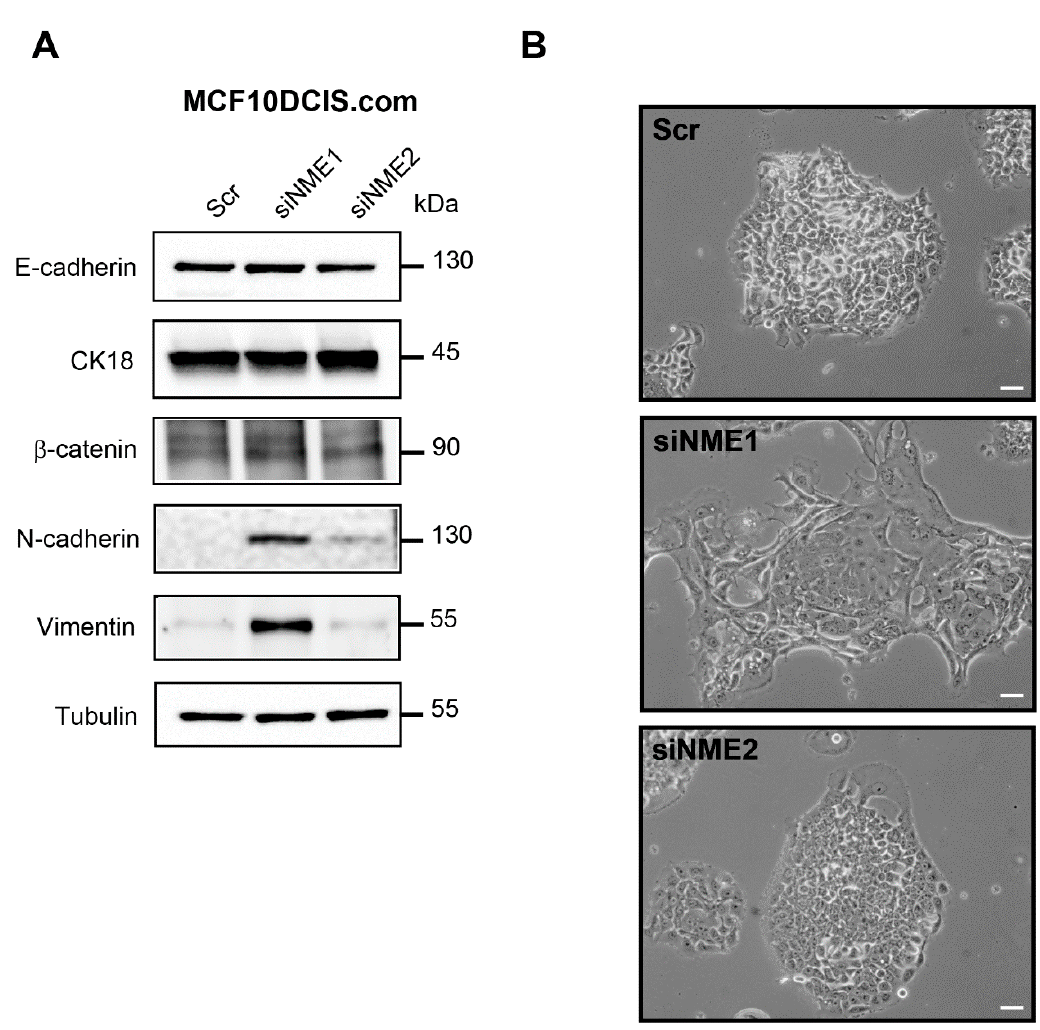
Figure 1. Depletion of NME1 from epithelial breast cancer cells induces an incomplete EMT. ( A ) MCF10DCIS.com human breast carcinoma cells, which have an epithelial-like phenotype, were treated with siRNAs to silence NME1 (siNME1) or NME2 (siNME2) or with a scrambled siRNA (Scr) as a control. Cell lysates were analyzed by Western blotting with antibodies against the indicated proteins. Equal loading was verified by Western blotting for tubulin. Molecular weights are indicated in kDa. ( B ) Phase-contrast microscopy of control and silenced cells as in ( A ) 72 h post-transfection. Scale bar, 20 µm.